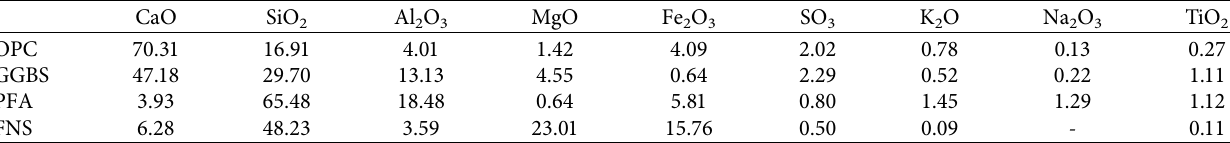
Table 1: Chemical composition of the materials used in this study (%).